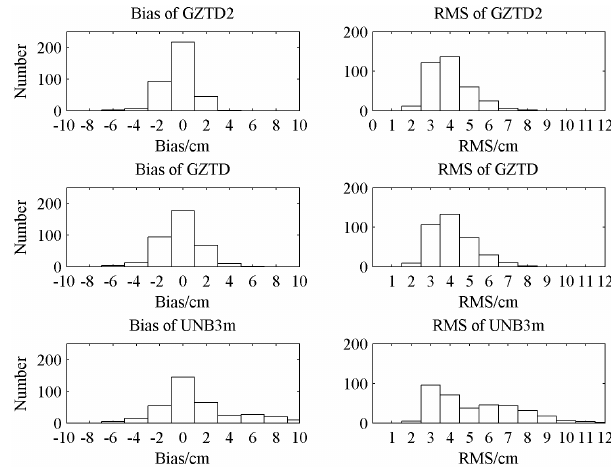
Figure 7. Histograms of bias and rms for three models.